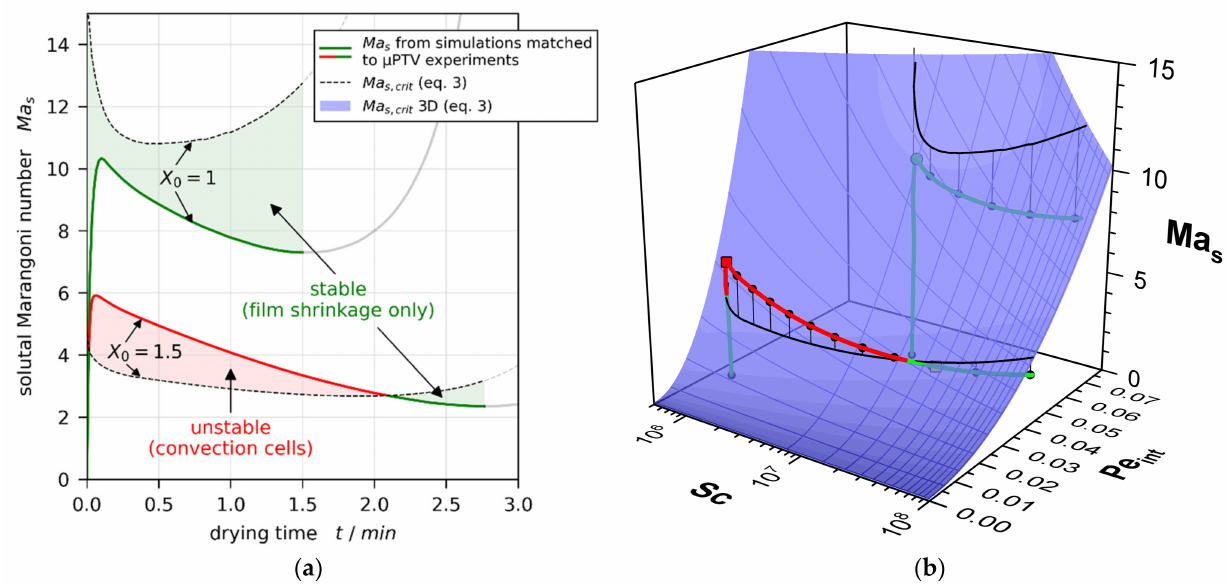
Figure 13. Transient solutal Marangoni number during drying of films with h gap = 200 µ m and X 0 = 1 and 2 g respectively, in comparison with the empiric power-law correlation for critical stability threshold. Exemplarily, one convectively stable and one initially unstable film is depicted. ( a ) Plotted over drying time. ( b ) Plotted as function of P é clet and Schmidt numbers. For better visualization, the 3D plot is provided in the Supplementary Material with animated rotation around the vertical